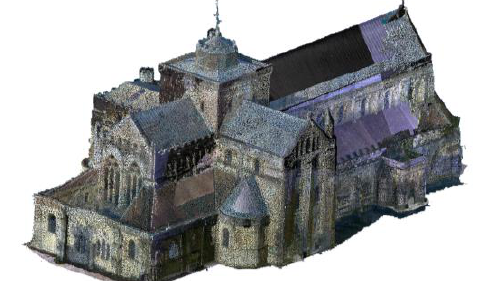
Figure 3. Registered point cloud from Romsey Abbey.